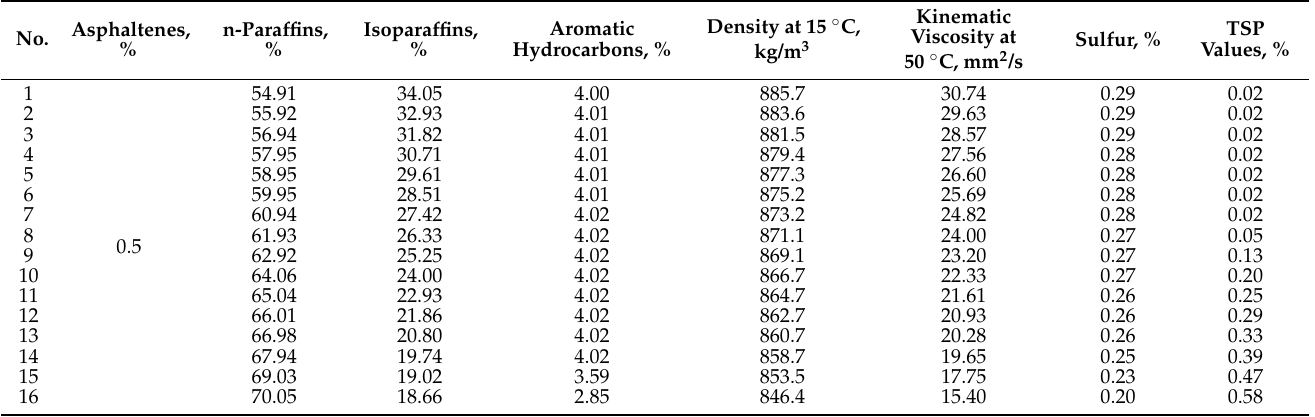
Table 3. Group composition, main quality indicators, and TSP values at an asphaltene content of 0.5 wt. % in the fuel composition.